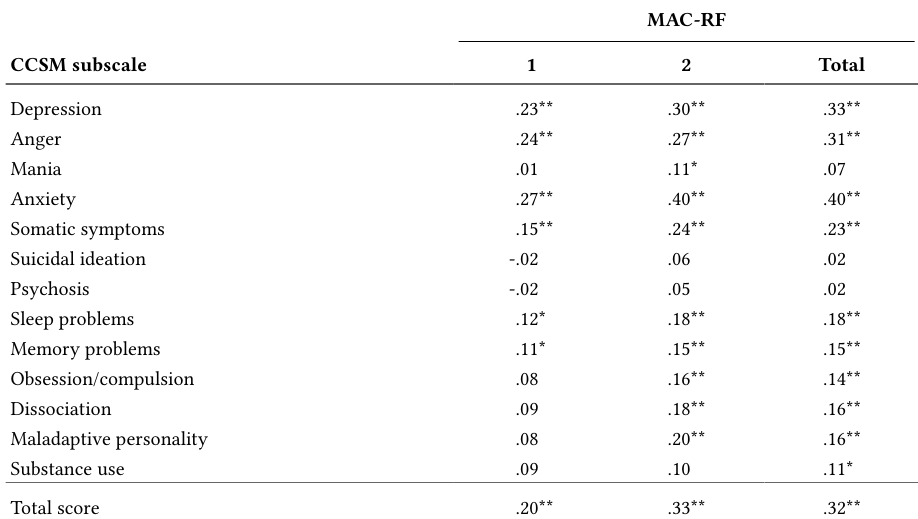
Correlations Between the MAC-RF and CCSM (N = 346) CCSM subscale Depression .23** .30** .33**